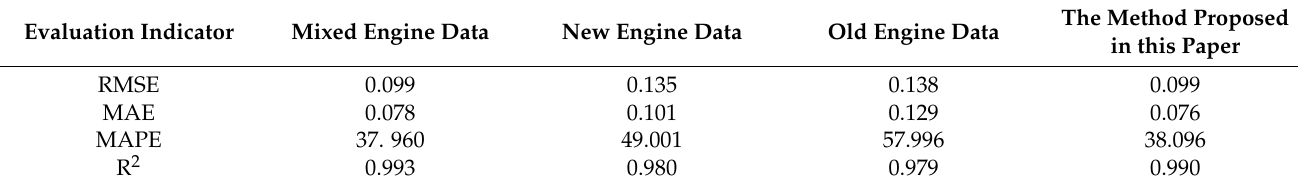
Table 5. Scores of the feature extraction model without Loss WSCE and